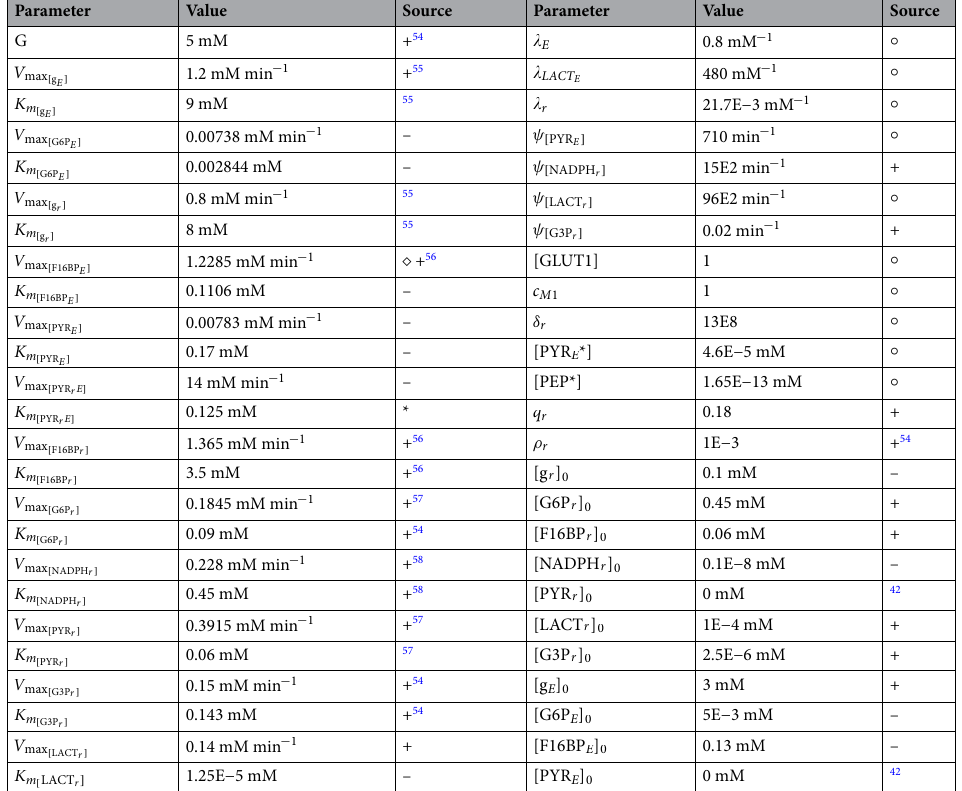
Table 1. Parameters and initial conditions for the numerical simulations under healthy conditions. The parameters marked as (+), are used exactly as they appear in Camacho et al. 50 , and the reference where they were originally reported is provided when applicable. The parameter marked as ( ⋄ ) is within ± 10% of the value reported in the provided reference. The parameters marked as ( ◦ ) are scaling constants added to this model and do not represent any real kinetic or concentration value in the cells. The parameters marked as (−) are estimated for this example by performing a systematic parameter sweep in which their values were changed by a small fraction. This sweep was iterated many times until the responses provided the best qualitative approximation to the available experimental data, as mentioned in “Model validation” section. The value of parameter K m [ PYR (marked with *) is equal to the value of parameter K m in 50 because the enzyme Lactate [ LACT ] rE ] dehydrogenase b (LDHB) enables the transformation of pyruvate into lactate, and vice